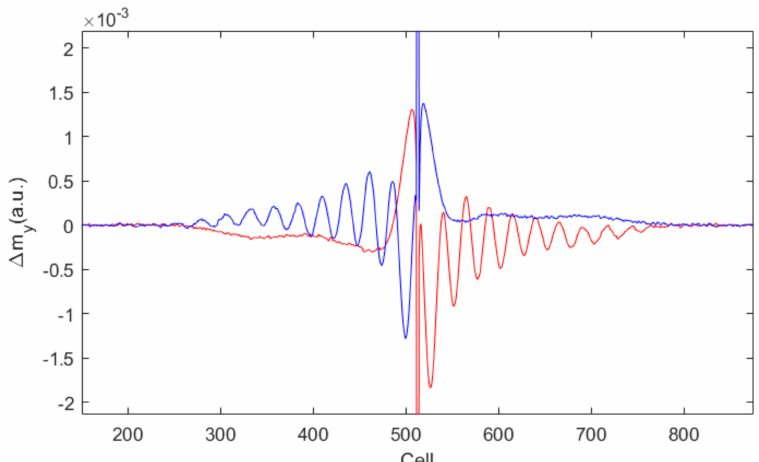
Figure 8. NdCo x -(10nm-Al)-Py. Temporal snapshot of the deviation of the y-component of the Permalloy reduced magnetization from its equilibrium value. The exciting field frequency is 2.5GHz. H DC = 0